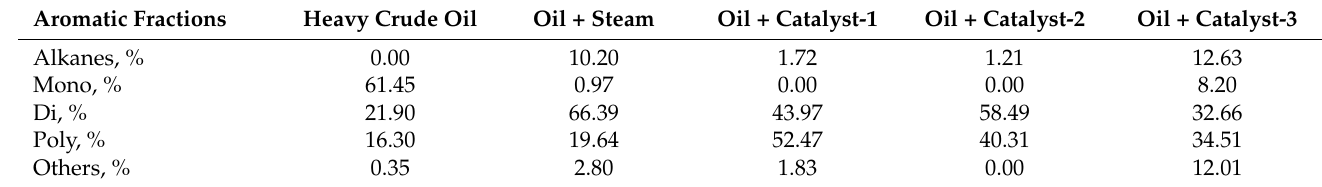
Table 7. GC − MS results of aromatic fractions of crude and upgraded